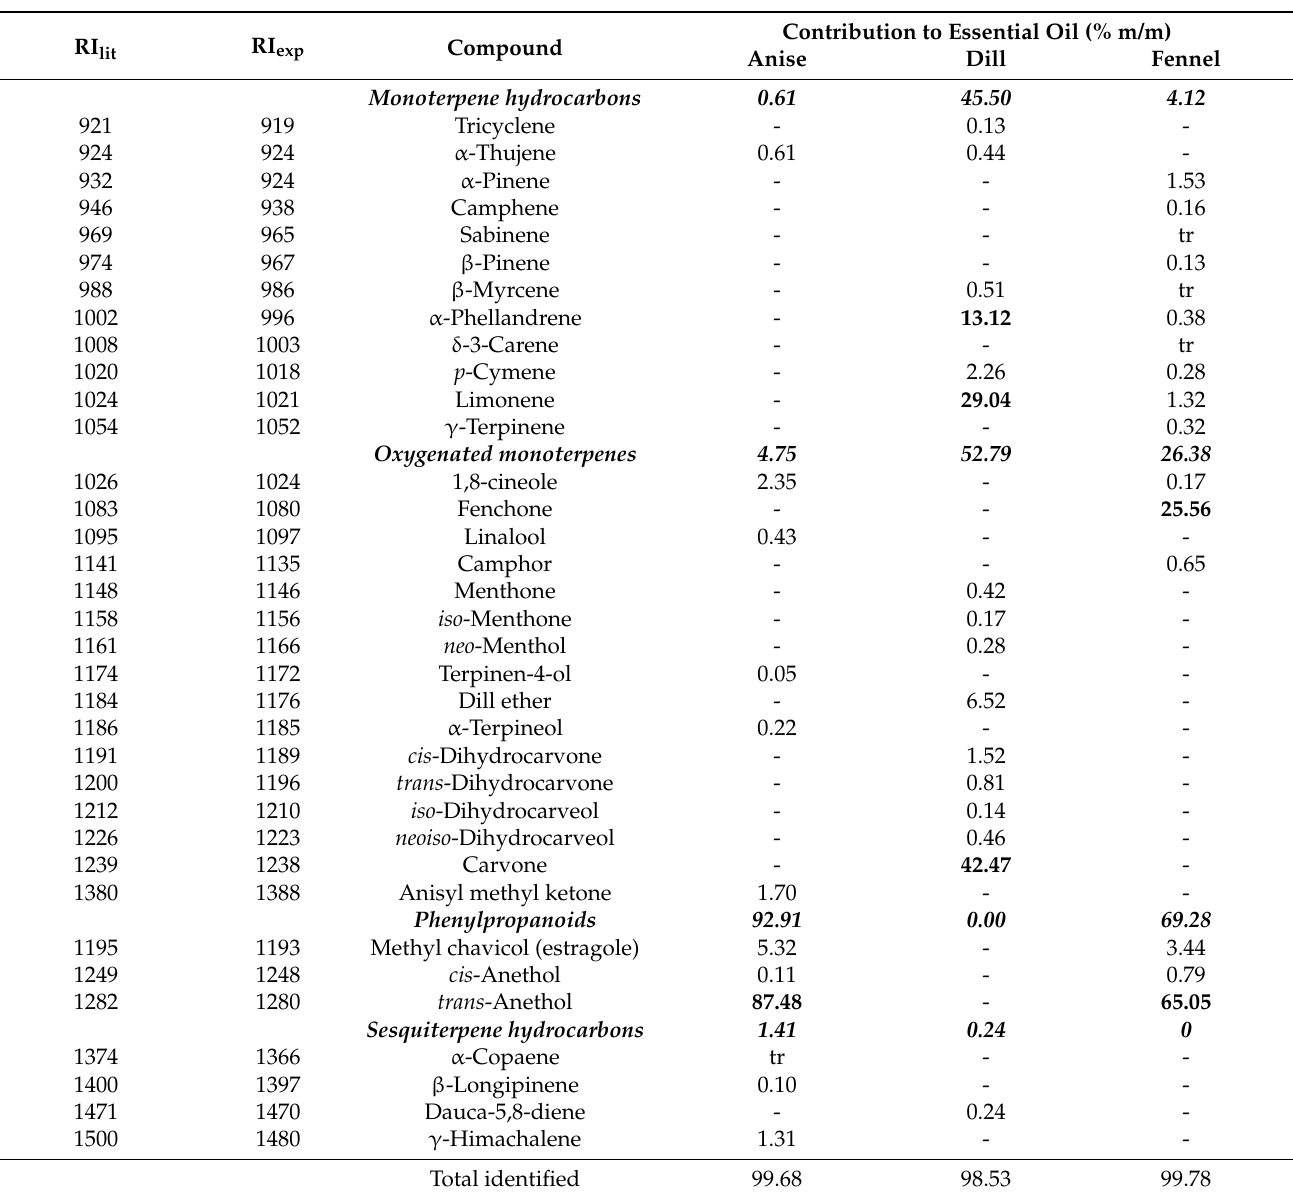
Table 1. Chemical composition of essential oils obtained from seeds of anise ( Pimpinella anisum ), dill ( Anethum graveolens ) and fennel ( Foeniculum vulgare ). Compounds are grouped according to their chemical class and total portion of each class is presented in bold. Contents of major compounds are also given in bold. RI lit —Kovats retention indices; RI exp —values for retention indices on the HP-5 column; tr—contents <